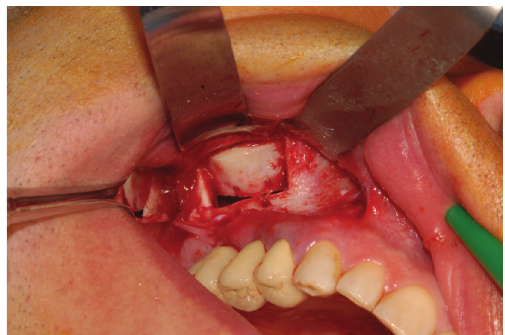
Figure 2: CBCT scans showing a dental implant displaced into the maxillary sinus.